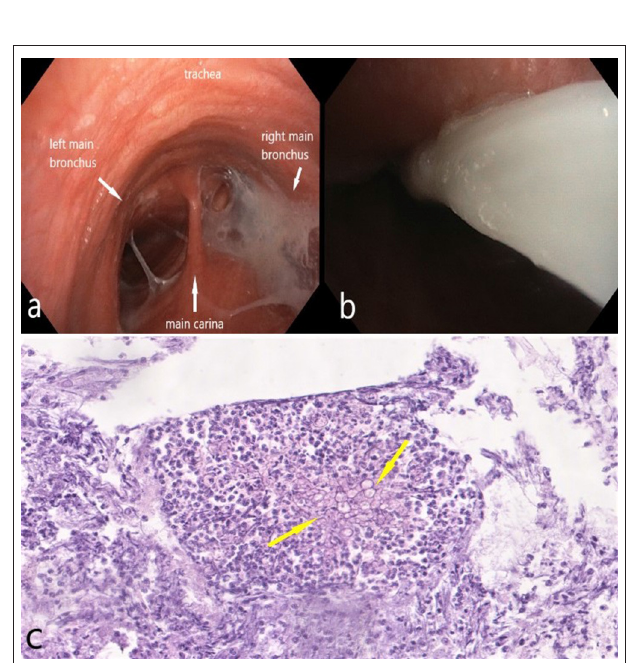
FIGURE 2 | Bronchoscopy: (a) main trachea - purulent bronchitis, more severe in the right main bronchus; the bronchial mucosa is dull, red, with dilated vessels; (b) thick, purulent mucus in the right main bronchus; (c) fungal hyphae (yellow arrows) in the bronchial wash (original magnification × 100).